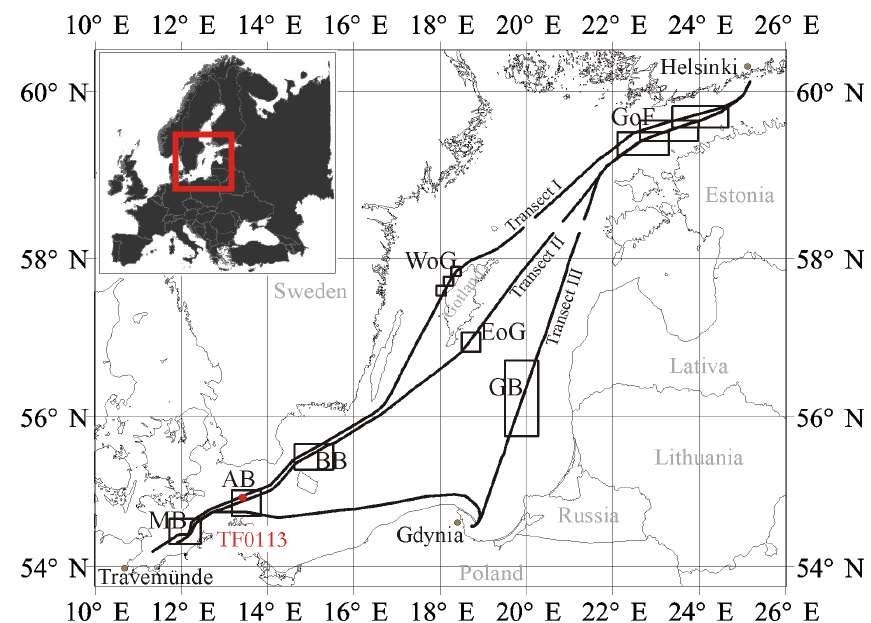
Fig. 1. Cruise tracks of the ship of opportunity Finnmaid . The ferry line crosses the Baltic Sea via three transects and connects Travem¨unde (Germany) with Helsinki (Finland) and Gdynia (Poland) in an interval of 2 to 3 days. Transect I passes the Mecklenburg Bight (MB), Arkona Basin (AB), Bornholm Basin (BB), West of Gotland (WoG) and the Gulf of Finland (GoF). Transect II records the same route but East of Gotland (EoG). Transect III passes Gdynia and the Gotland Basin (GB). Boxes indicate selected areas for detailed investigations (see also Table 1). Station TF0113 is part of a regular monitoring program of the Leibniz Institute for Baltic Sea Research Warnem¨unde.